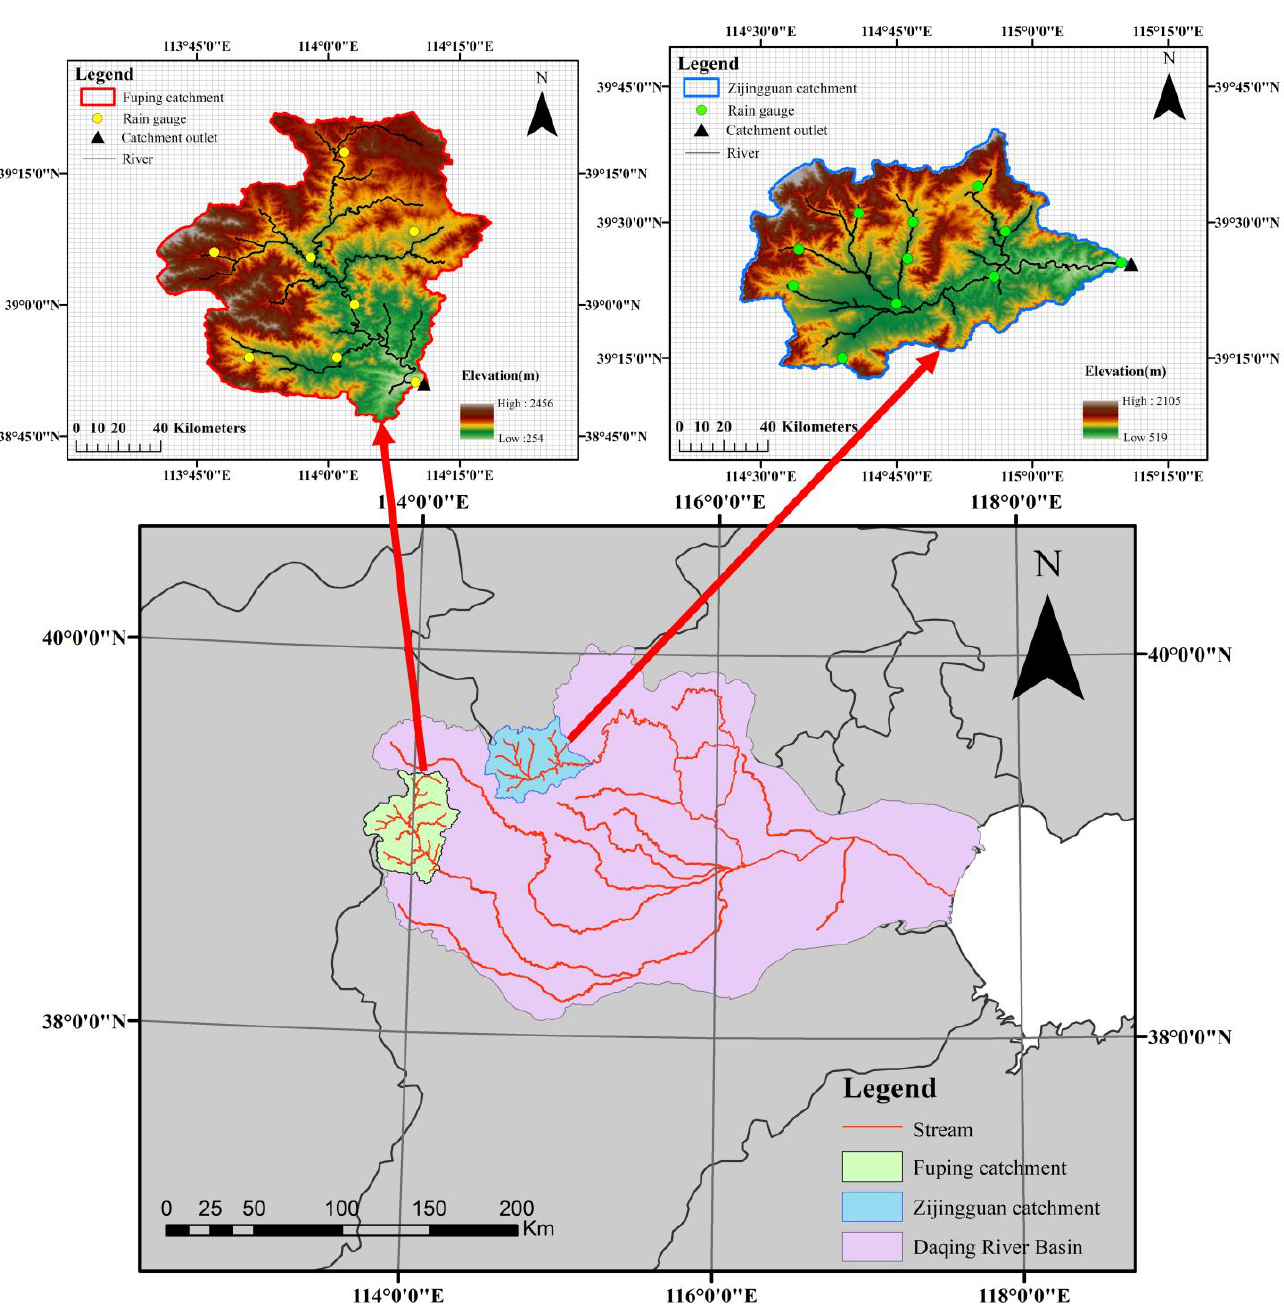
Figure 1. Locations of the study area and the catchments covered by the WRF innermost domain.